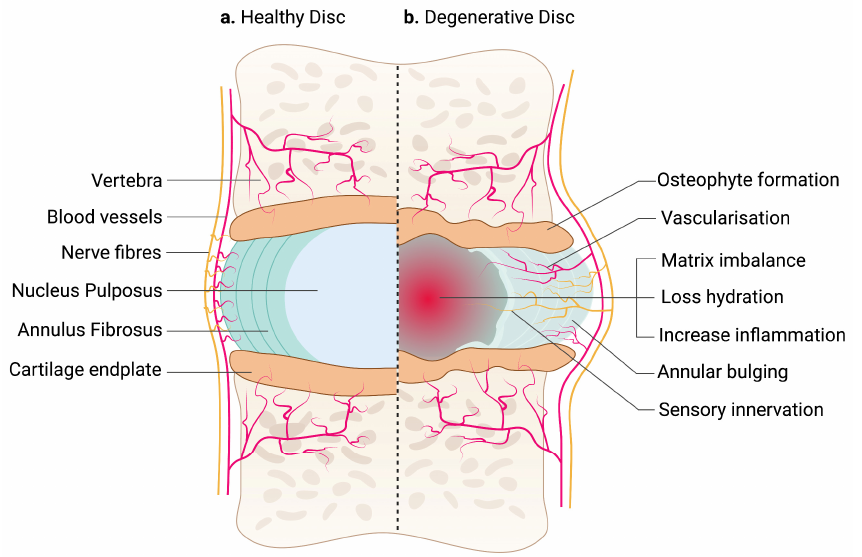
outer fibrous AF and a center gelatinous NP, which is confined by hyaline CEP. Arteries supply the outermost region of AF, while sinuvertebral nerves innervate the outer third of the AF. NP is avascular and aneural. ( b ) Degenerative IVD is characterized by matrix imbalance, dehydration and inflammation. Blood vessels and nerve fibers are also presented in the inner region of AF and NP. Structural changes in the IVD, including annular bulging and osteophyte formation in the CEP, affecting tissue biomechanics. The schematic was created with